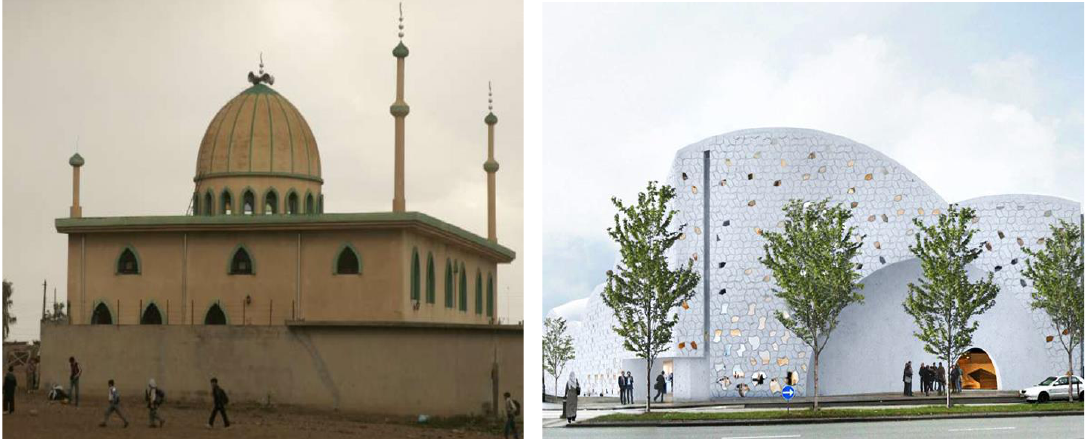
Fig. 4. An example of operational cultural mosque building in Iraq on left side while a proposed modern sustainable and self-healing based green mosque building on the right side ( Tsangouri et al., 2015)